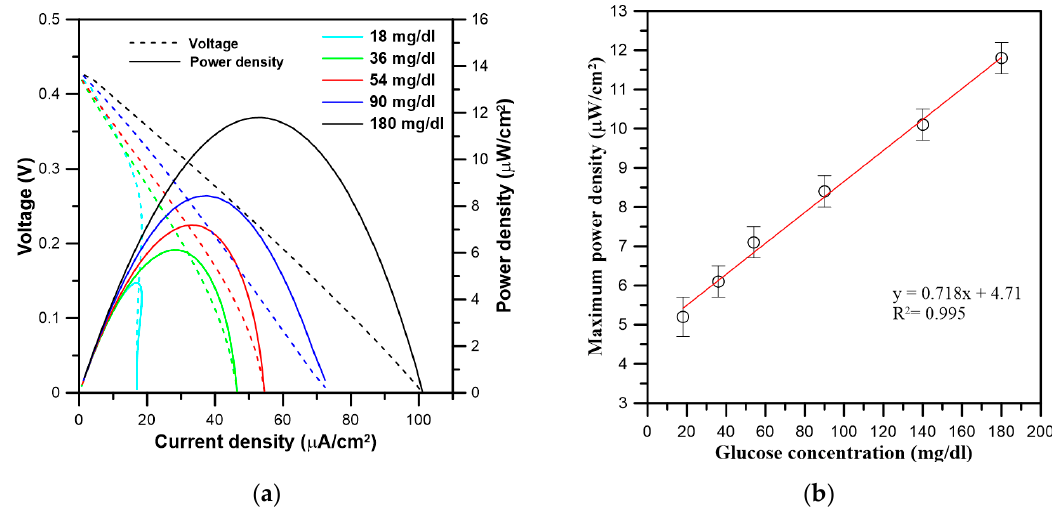
Figure 3. ( a ) Polarization curves, and current and power densities of the N-EFC at various standard glucose concentrations from 10 to 180 mg/dl in 0.1 M phosphate buffer, pH 7.0. ( b ) The relationship between the maximum power density of the N-EFC and the glucose analyte concentration taken from an averaged triplicate experiment (R 2 = 0.995).